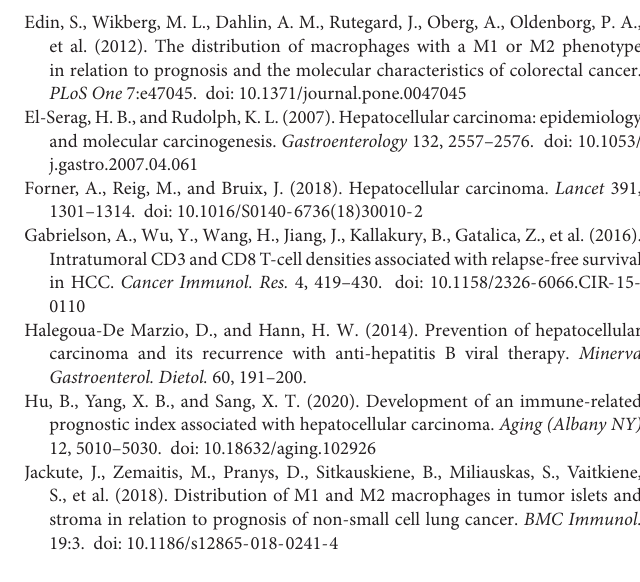
Supplementary Figure 1 | (A) Venn diagram of differentially expressed immune genes. (B–G) The difference in expression of C6, EGR1, C8B, CFP, CXCL2, and CCL19 genes in tumor and paracancerous tissues, respectively. ** P < 0.01 and **** P < 0.0001. Supplementary Figure 2 | The KM curve of the five genes. Supplementary Figure 3 | (A) RiskScore, survival time, and 5-gene expression in GSE14520. (B) ROC curve and AUC of 5-gene signature classification. (C) KM survival curve distribution of 5-gene signature in independently validated data set GSE14520. Supplementary Figure 4 | (A) RiskScore, survival time, and 5-gene expression in HCCDB18. (B) ROC curve and AUC of 5-gene signature classification. (C) KM survival curve distribution of 5-gene signature distribution in